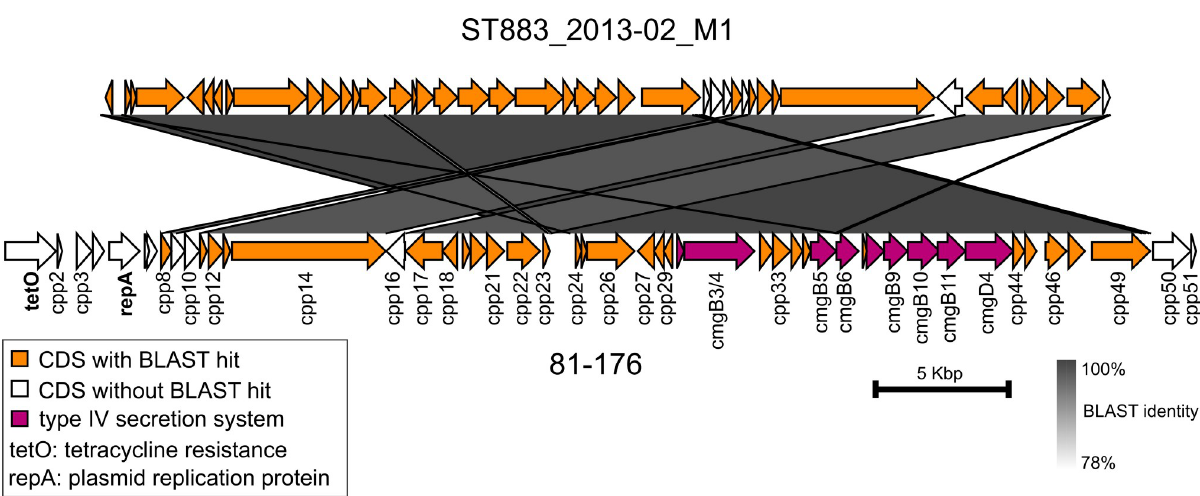
Fig 7. Nucleotide sequence comparison of pTet. The pTet-like element from the outbreak type isolate (ST883_2013–02_M1) is compared against the pTet plasmid from the C . jejuni strain 81–176 (RefSeq accession no. NC_006135.1). Arrows indicate predicted coding sequences (CDS).